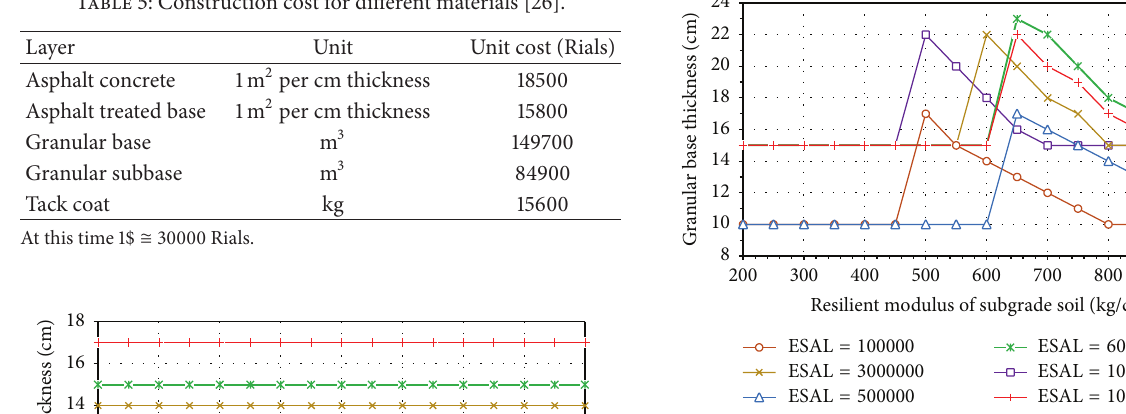
Figure 3: Optimal design thickness of granular base for secondary rural roads.